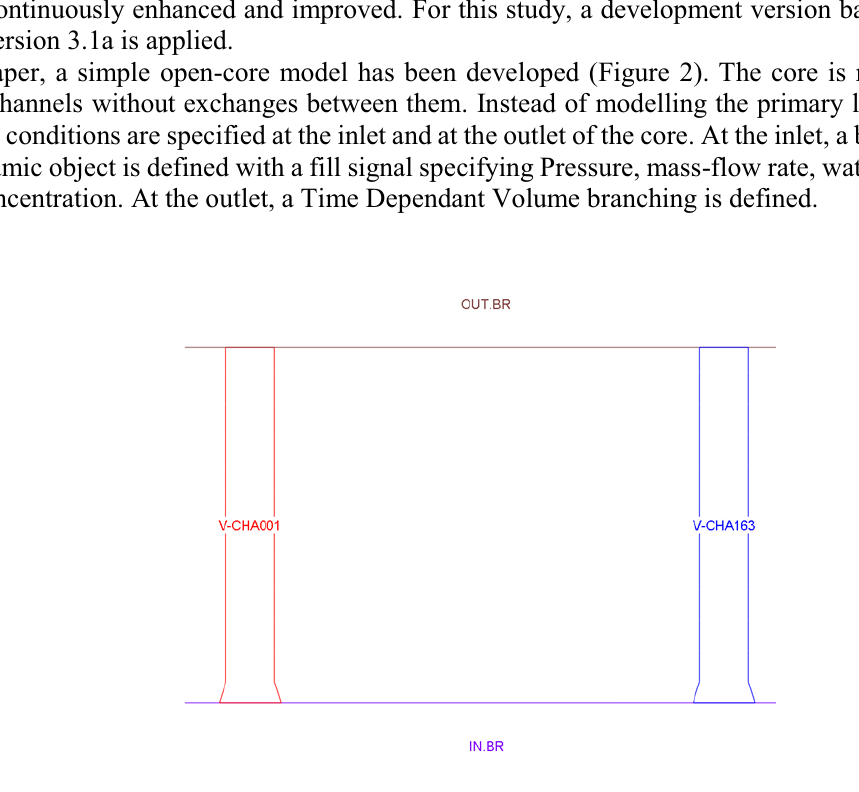
Figure 2: Scheme of the ATHLET open core